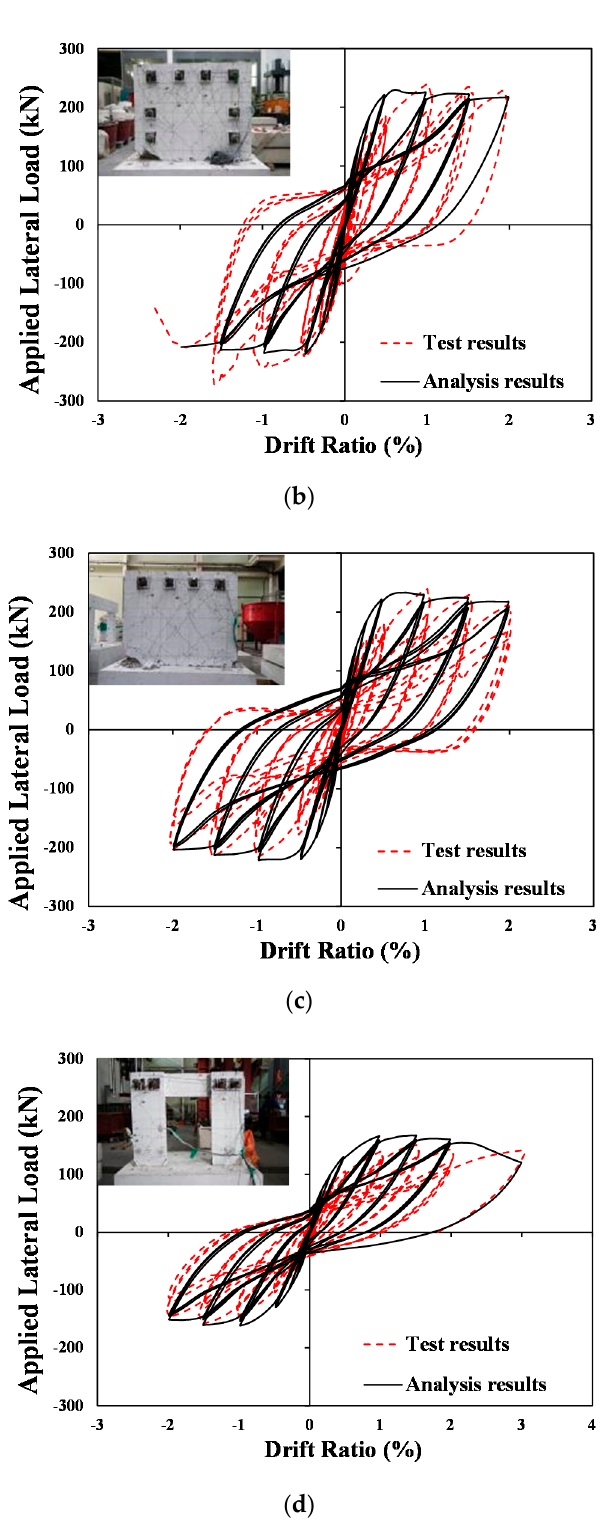
Figure 9. Lateral load-drift ratio of specimens: ( a ) Specimen FC; ( b ) Specimen FBC; ( c ) Specimen FB; ( d ) Specimen FPB.